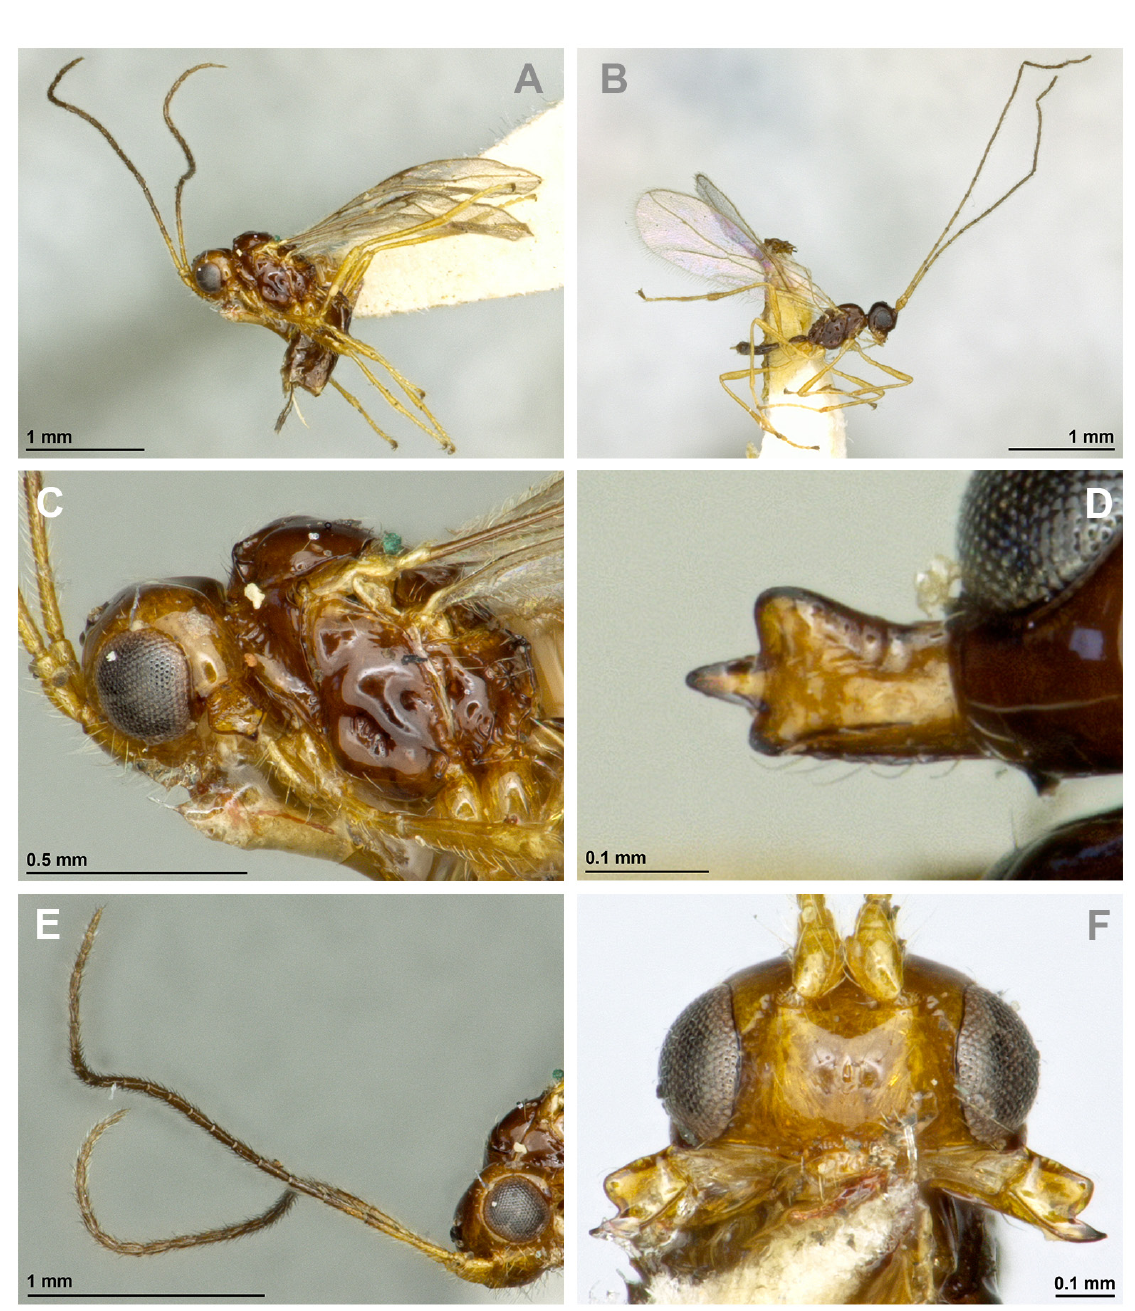
Fig. 62. Asobara taylori Peris-Felipo, sp. nov., A, C–F: ♀, holotype (BMNH); B: ♂ (BMNH). A–B . Habitus, lateral view. C . Head and mesosoma, lateral view. D . Mandible. E . Antenna. F . Head, front